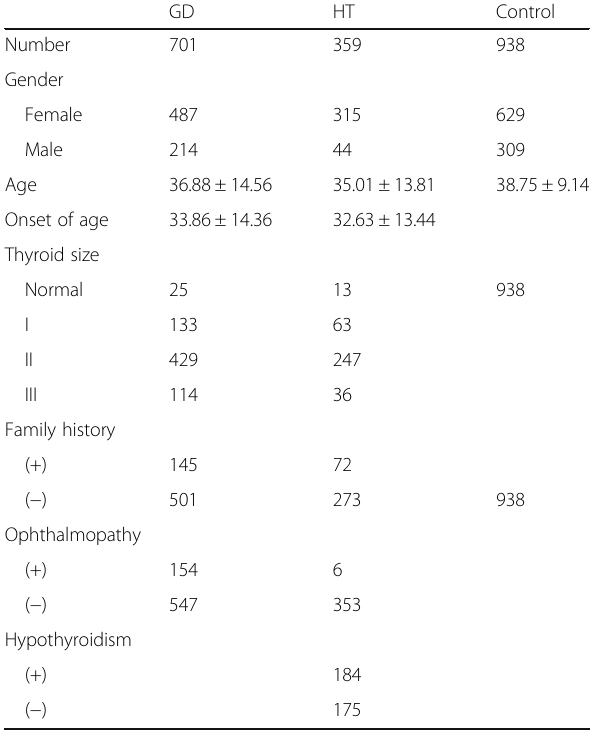
Table 1 Clinical data of AITD patients and